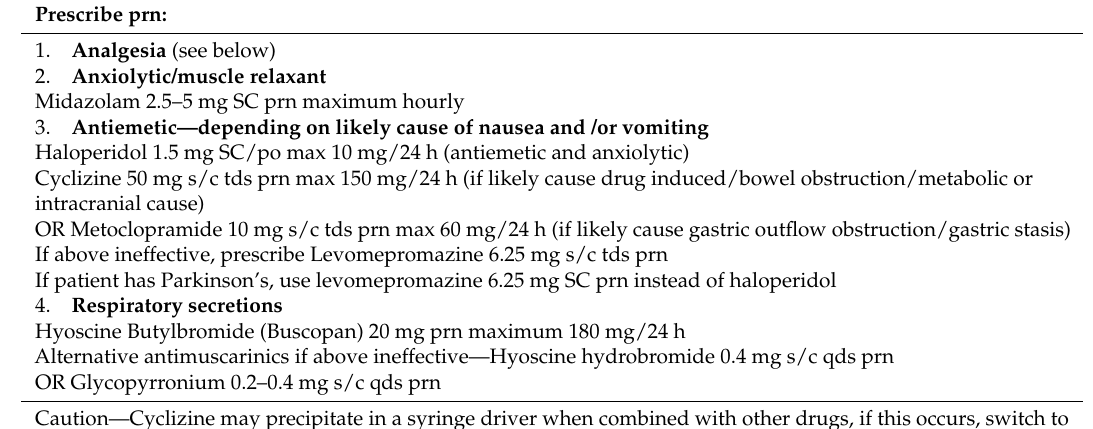
Table 2. Anticipatory prescribing recommendations